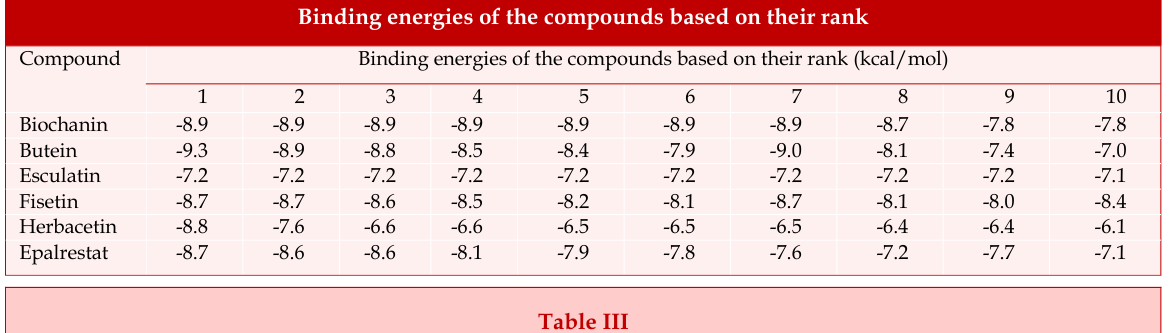
Inhibition Constant of the compounds based on their rank (mM, a µM) Compound